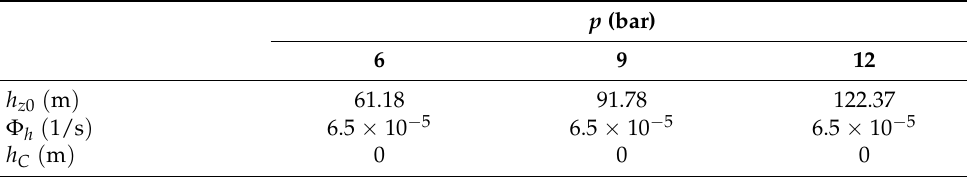
Table 6. Parameters in the initial and boundary conditions (4) of the hydraulic head depending on the pressure of the incoming